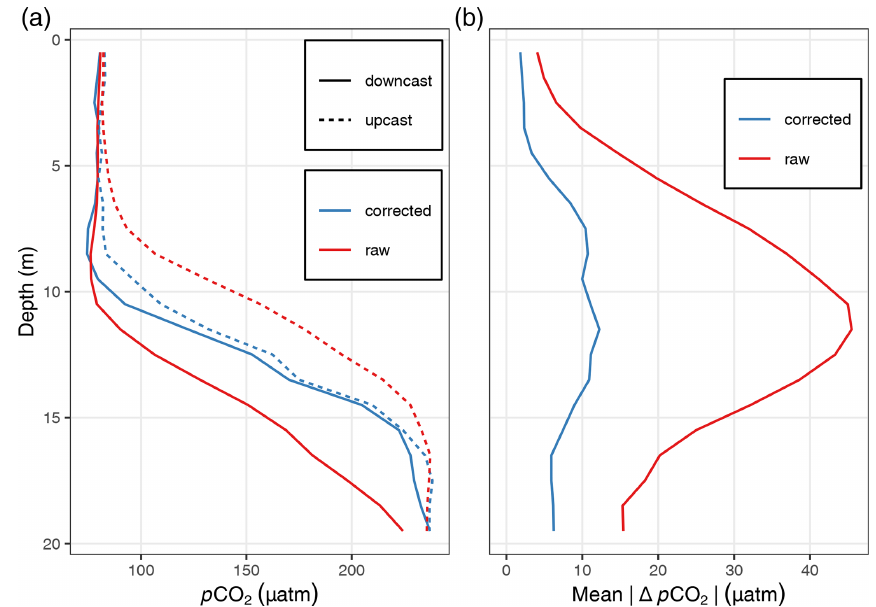
Figure A2. Comparison of p CO 2 profiles before (raw) and after (corrected) response time correction: (a) exemplary up- and downcast p CO 2 profiles at one station and (b) mean absolute p CO 2 difference between up- and downcast profiles across all profiles included in the quality